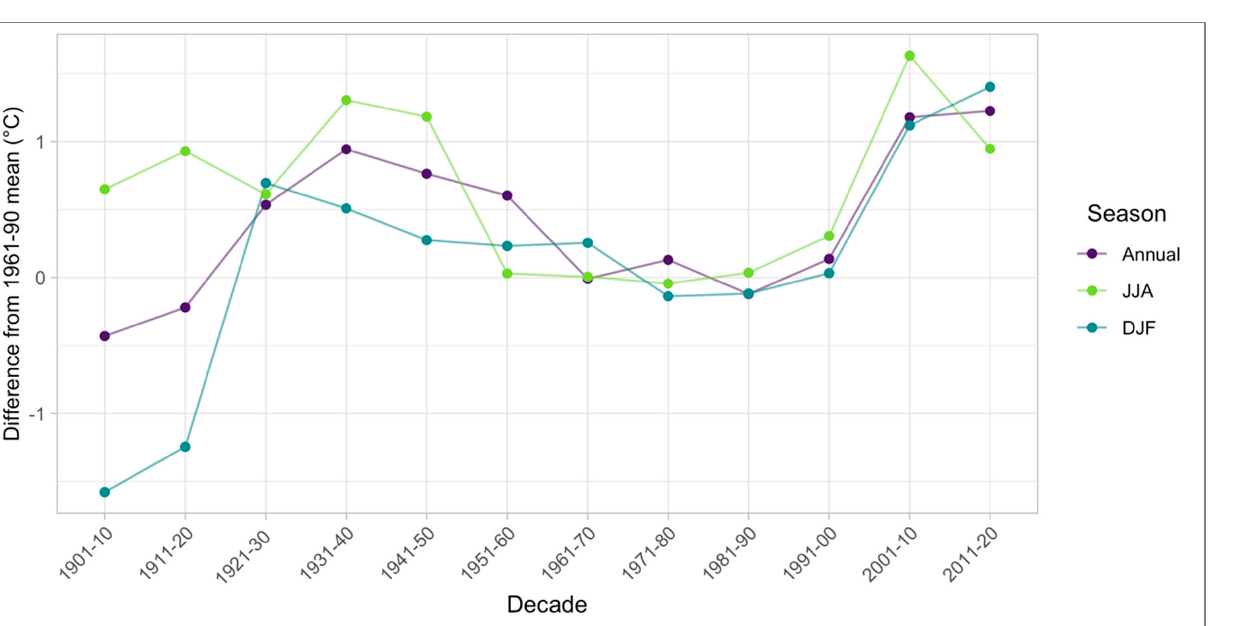
230 Figure 4. Long-term temperature anomalies for each month per decade, 1901–2020, Bolungarvík 231 average. The figure presents a “temperature circle” for each decade. There are 12 outer segments for 232 each month, labelled chronologically and progressing clockwise. The uppermost and righthand “J” 233 is January, the “F” to the right is February, and so on. Each color represents the difference in degrees 234 Celsius compared to the 1961–1990 reference period. The color in the center represents the annual 235 average temperature anomaly for the decade. 236 When examining a larger area, the analyses show similar temperature patterns to 237 those in Bolungarvík during the last sixty to seventy years. The analysis of the data from 238 stations with ≥ 60 years of continuous temperature collections, i.e., Gjögur (1949–2020), 239 Hornbjargsviti (1949–2020), Æðey (1954–2020), Reykhólar (1961–2020) and Lambavatn 240 (1961–2020), show that all three components analyzed, i.e., the annual, summer and 241